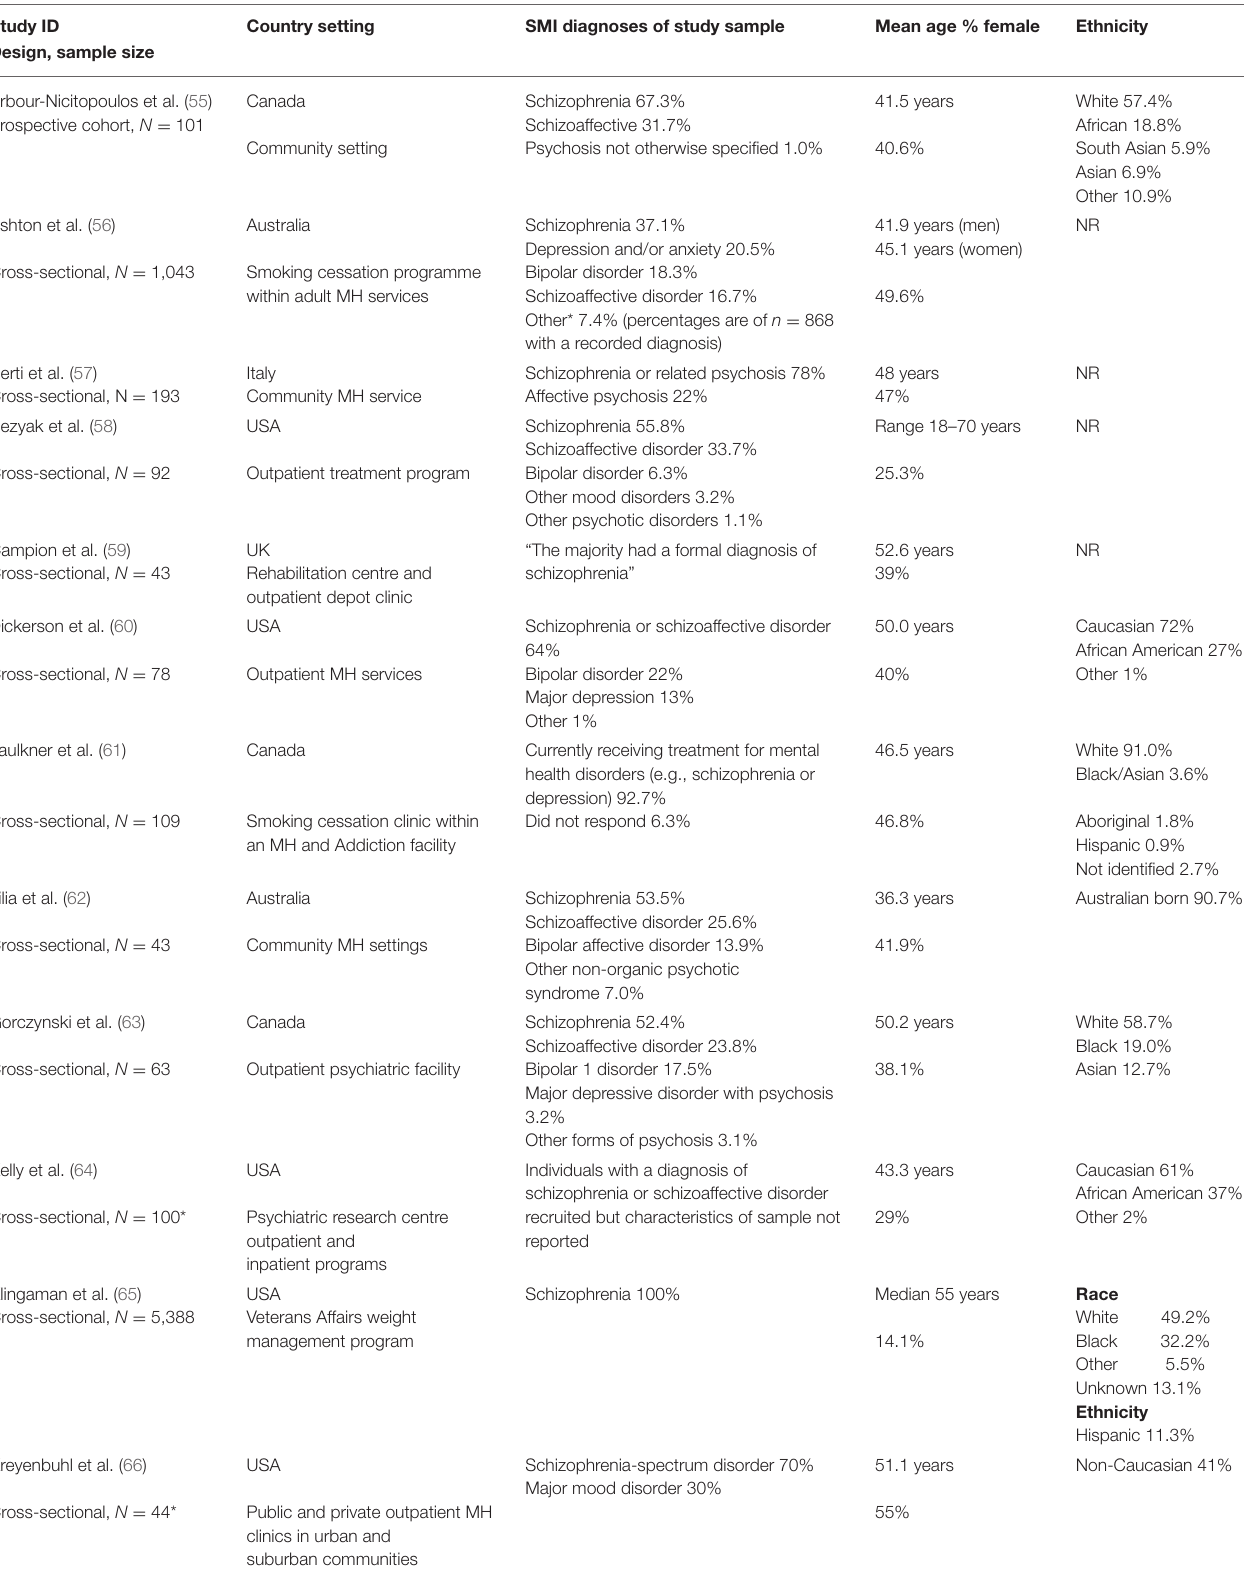
TABLE 4 | Characteristics of included